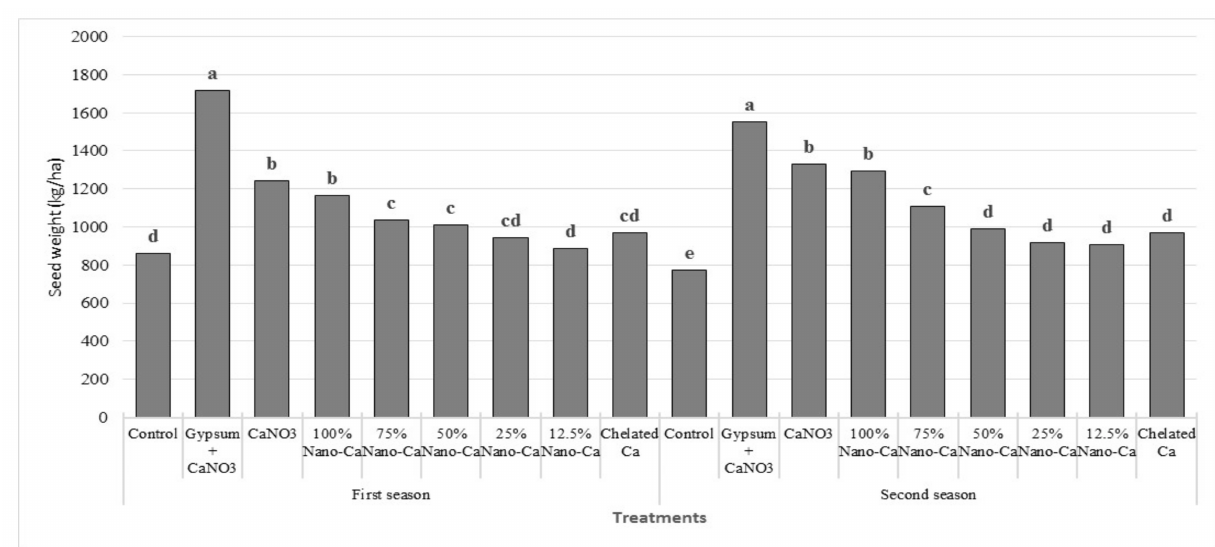
Figure 2. Effect of conventional calcium and nano calcium forms on seed yield (kg ha − 1 ) in peanuts during the two seasons of 2015 and 2016 under sandy soil conditions. Columns labeled with different letters are significantly different at p ≤ 0.05.